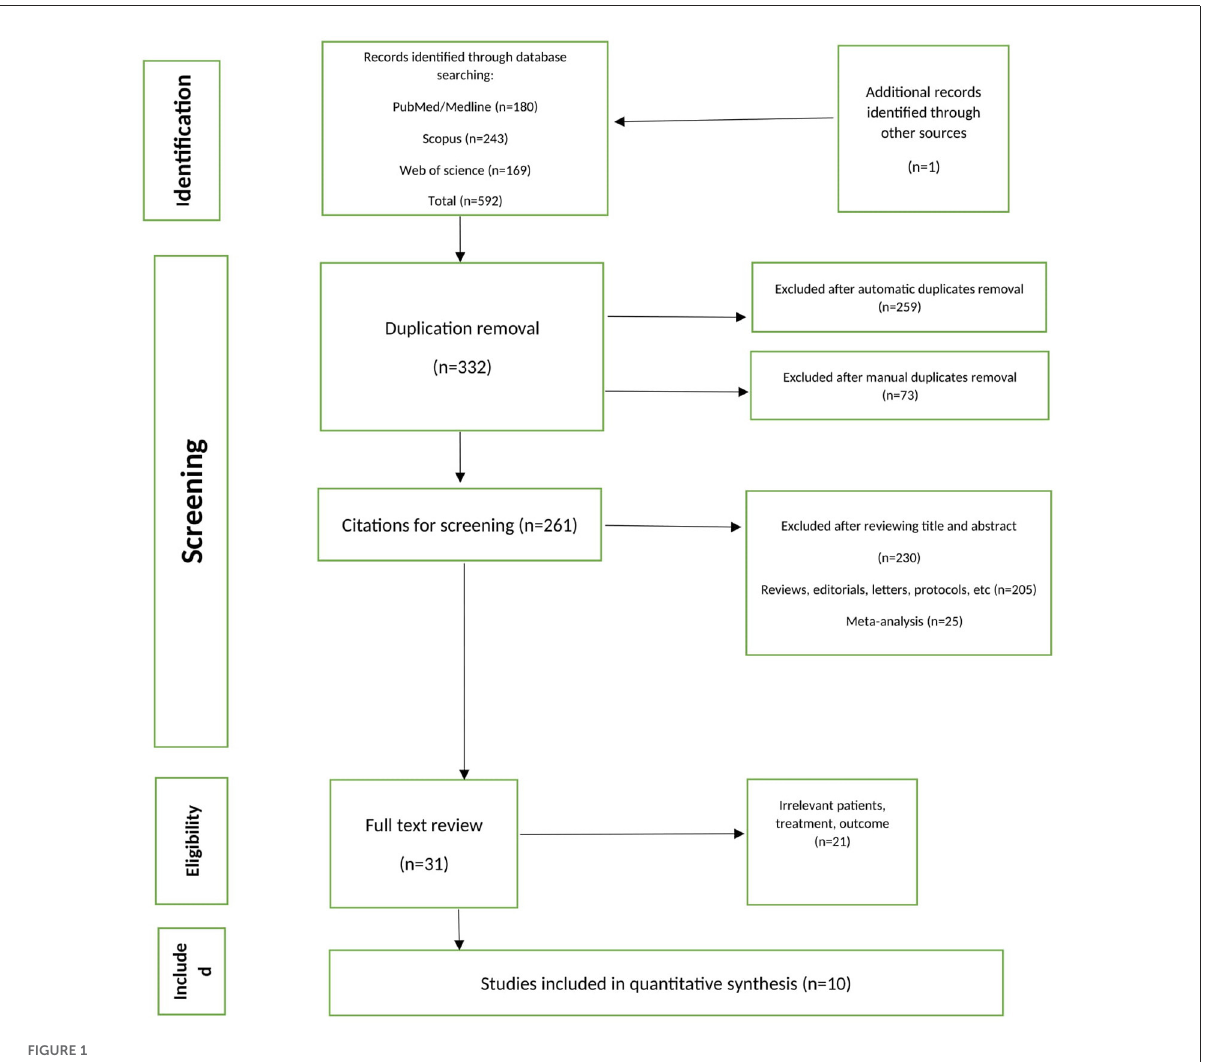
FIGURE1 Flowchart of the studies